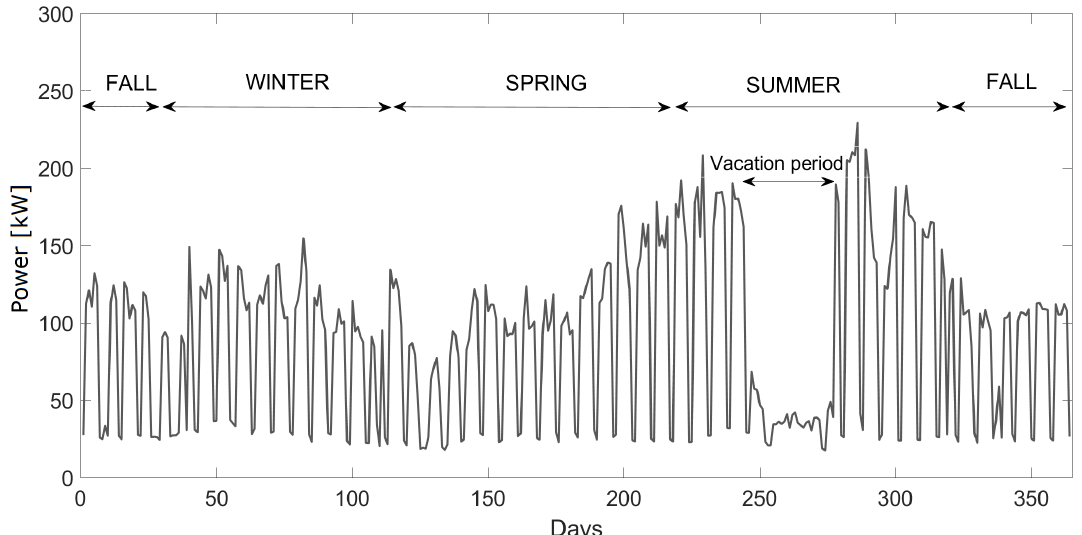
Figure 3. Electricity consumption: